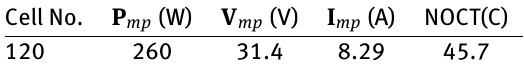
Table A10: PV data and characteristics. Cell No.